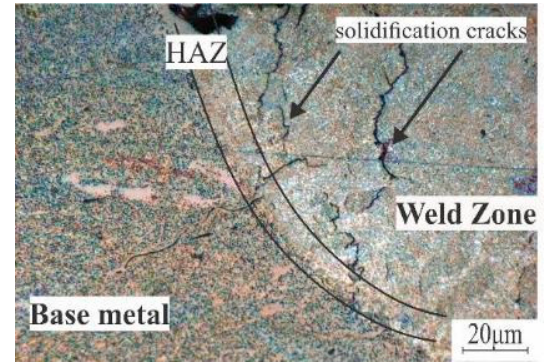
Figure 6. Laser-melted zone (LMZ) of the as-cast AA7075-standard.